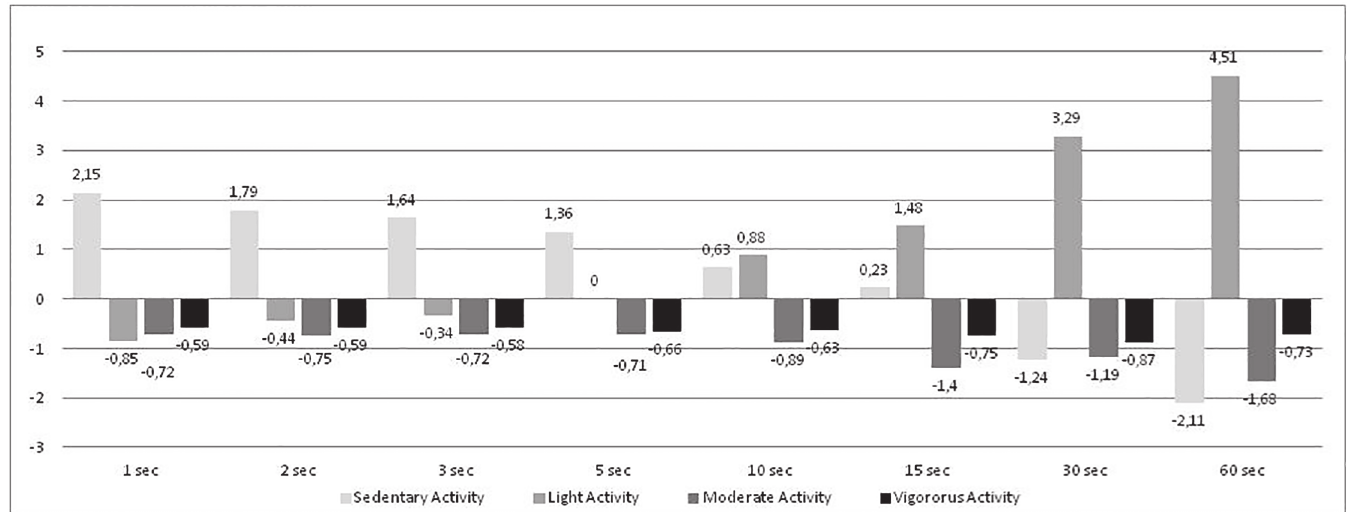
Fig 3. Differences between short and long PE lessons by epoch for each PA intensity. Note: Values are expressed in minutes. Values of long lessons have been subtracted from short